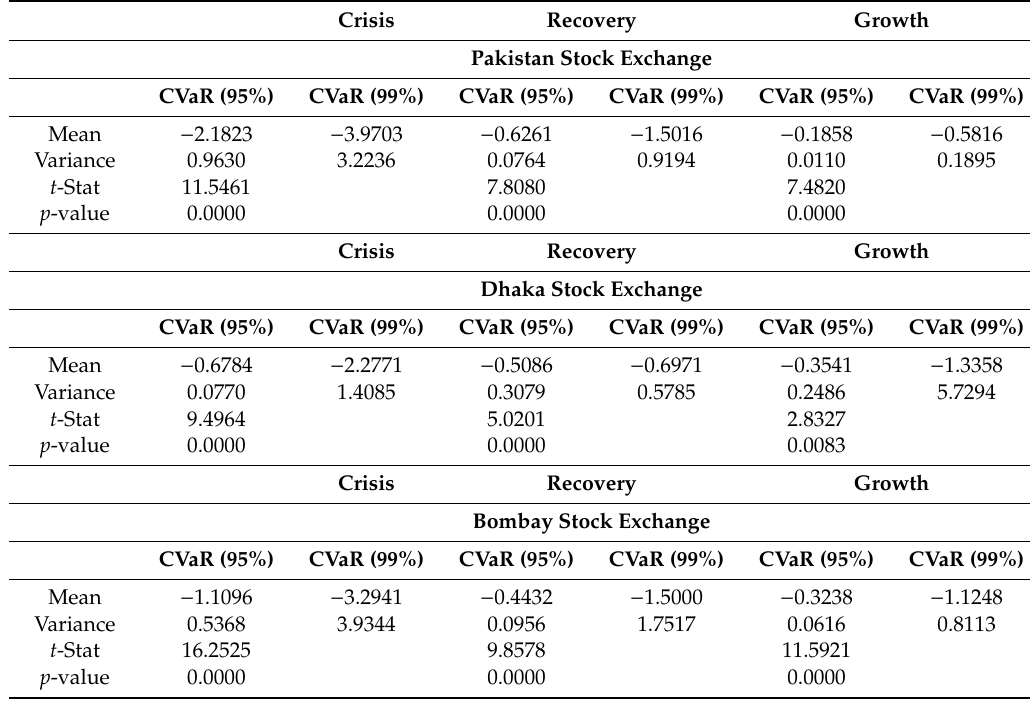
Table A5. Comparison of CVaR (95%) and CVaR